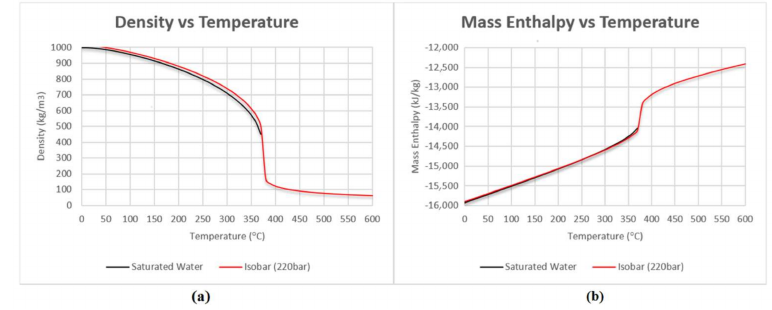
Figure 2. Saturated water and critical steam HYSYS graphs ( a ) density; ( b ) enthalpy vs